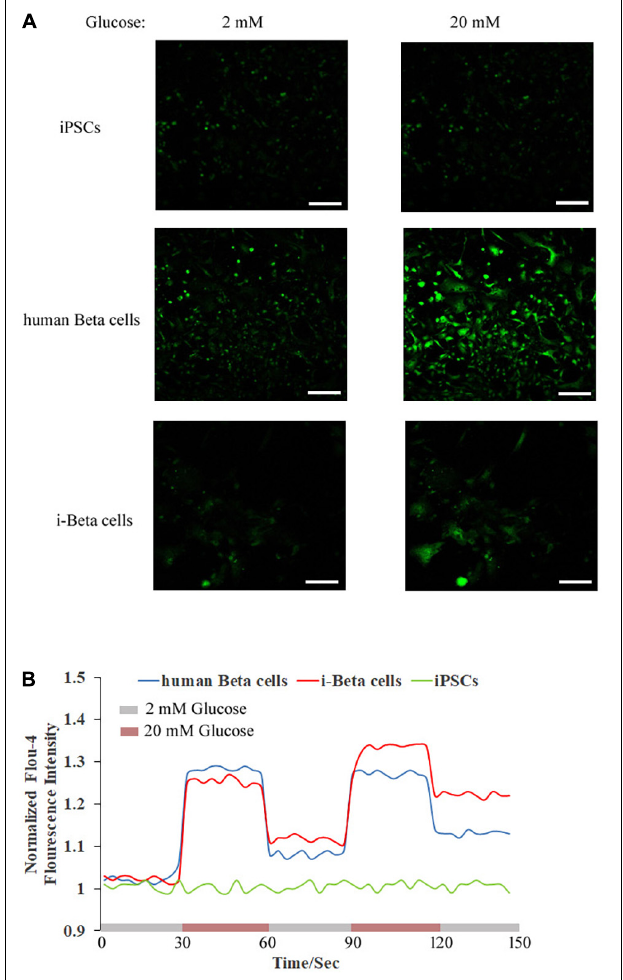
FIGURE 3 | Cytosolic Ca 2 + flux in response to multiple sequential high glucose stimulations. (A) Fluorescence images of Fluo-4 staining after treatment with various concentrations of glucose in human beta cells, i-Beta cells, and iPSCs. (B) Representative measurements of the dynamic normalized Fluo-4 fluorescence intensity in human beta cells, i-Beta cells, and iPSCs. i-Beta cells and human beta cells, but not iPSCs, responded to sequential glucose stimulations by increasing intracellular Ca 2 +